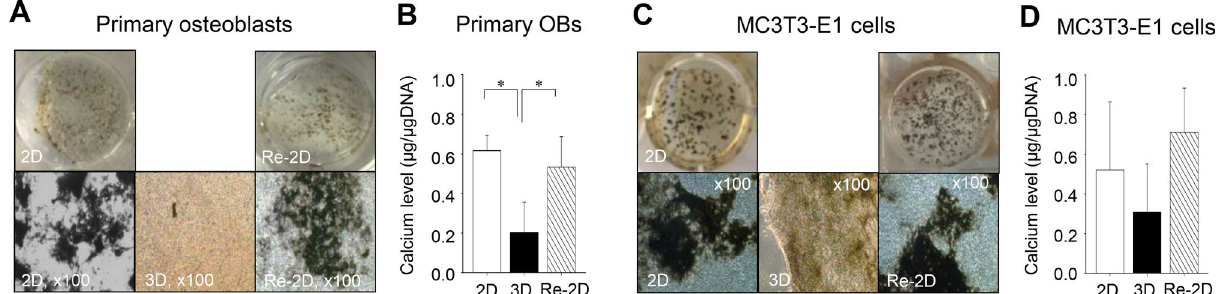
Figure 1. Calcium deposition. Representative photomicrographs of Von Kossa-stained primary osteoblast cultures ( A ) and MC3T3-E1 cell cultures ( C ). Cells were cultured for 21 days in osteogenic medium